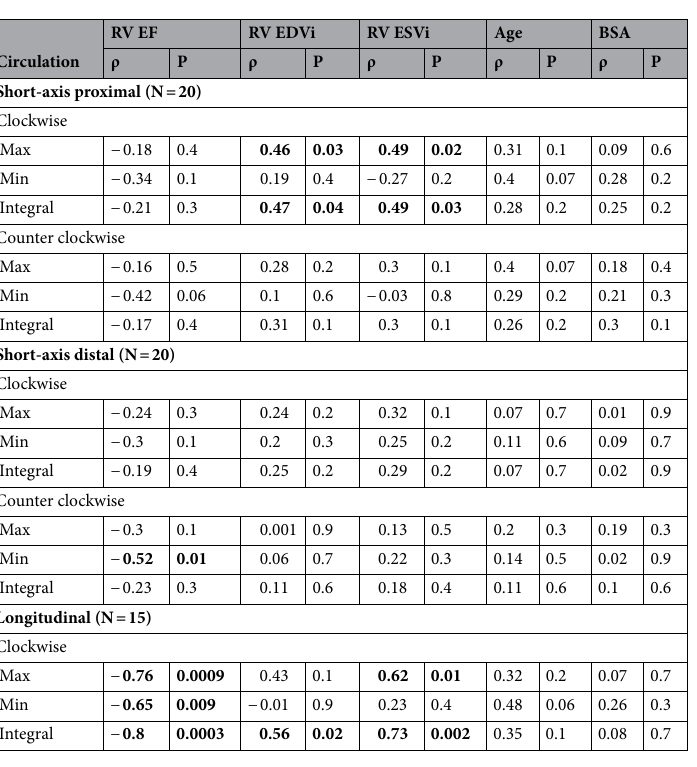
Table 3. Correlation between circulation in the main pulmonary artery and right ventricular function. Clockwise circulation in the short-axis proximal MPA had significant correlation with RVEDVi. Counterclockwise circulation in the short-axis distal MPA had a significant negative correlation with RVEF. The clockwise longitudinal circulation had significant correlations with the RVEF, RVEDVi, and RVESVi. p-value (P) from Spearman signed rank test. Boldface indicates statistically significance (p < 0.05). RV right ventricular, EF ejection fraction, EDVi end-diastolic volume indexed for body surface area, ESVi end-systolic volume indexed for body surface area, BSA body surface